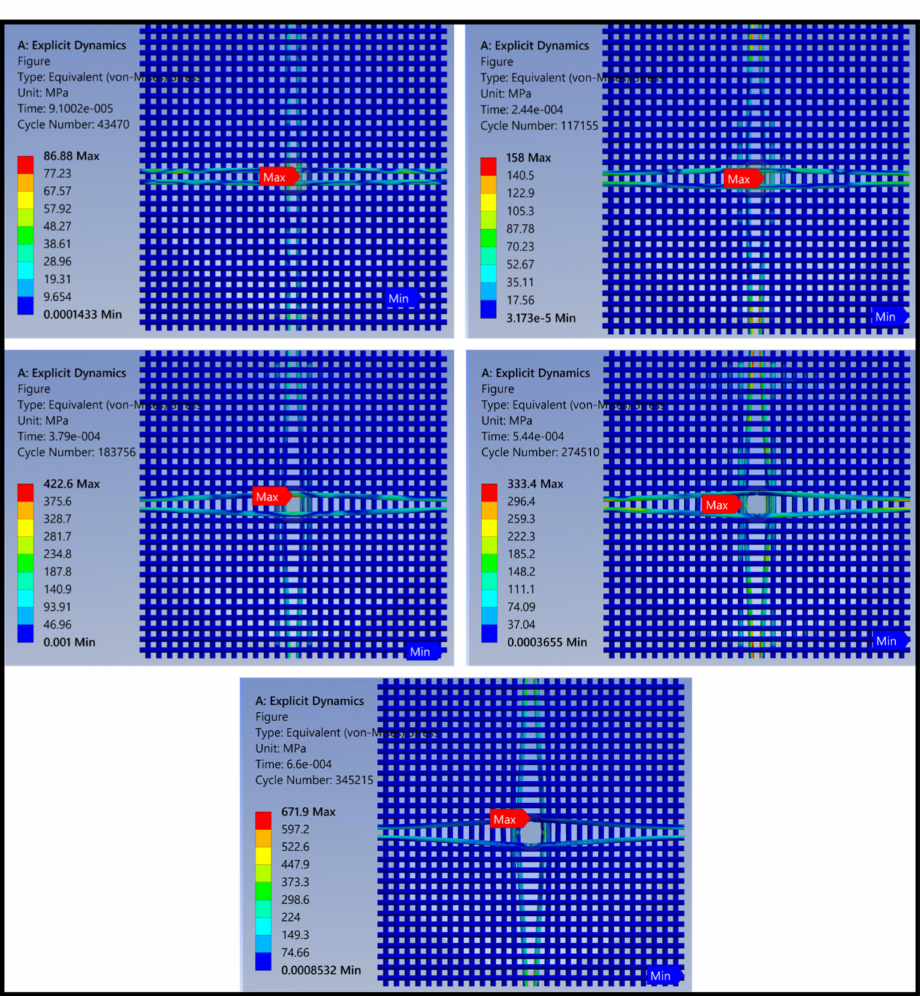
Figure 16. Damage morphologies obtained from the finite element method (FEM) results (stress diagram of the overall